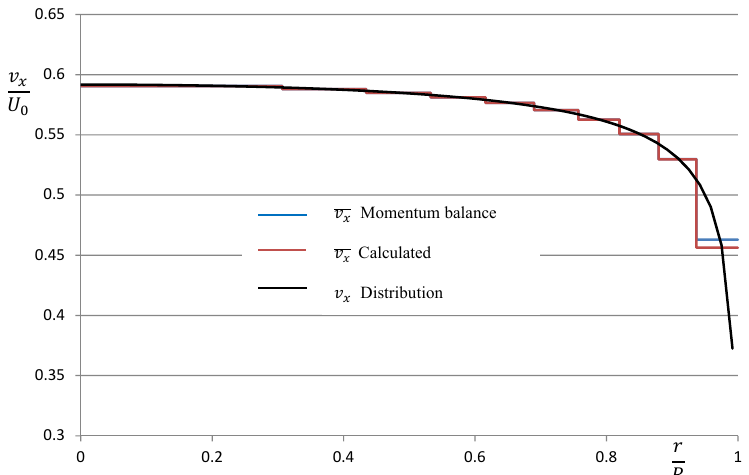
ρU 2 ) = − 0 . 8888 and λ = 1 . 018: the calculated distribution, the calculated average per 0 2